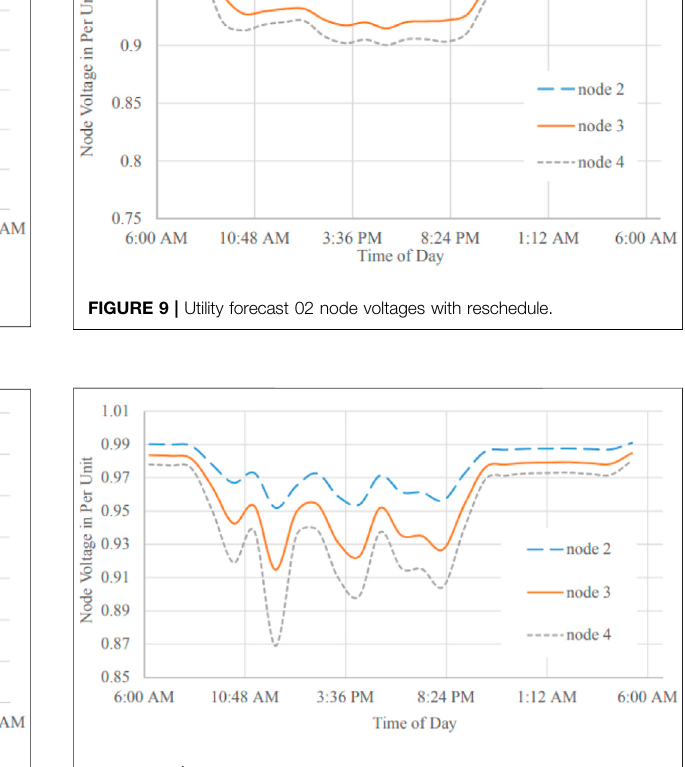
FIGURE 10 | Without rescheduling, node voltages for utility forecast 03.